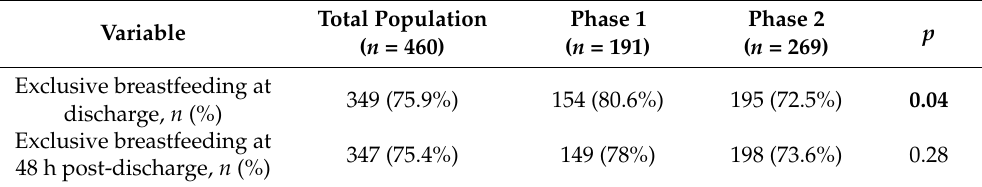
Table 4. Breastfeeding outcomes: comparison between Phase 1 and Phase